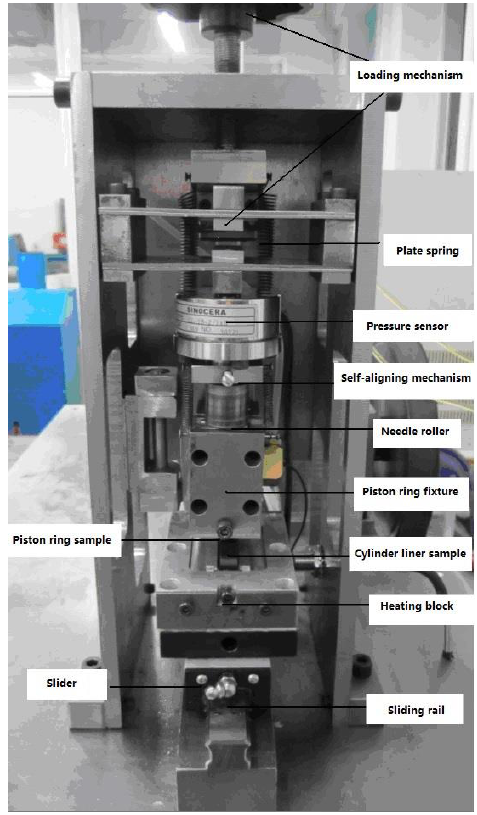
Figure 3. Piston ring reciprocating cylinder liner test rig.